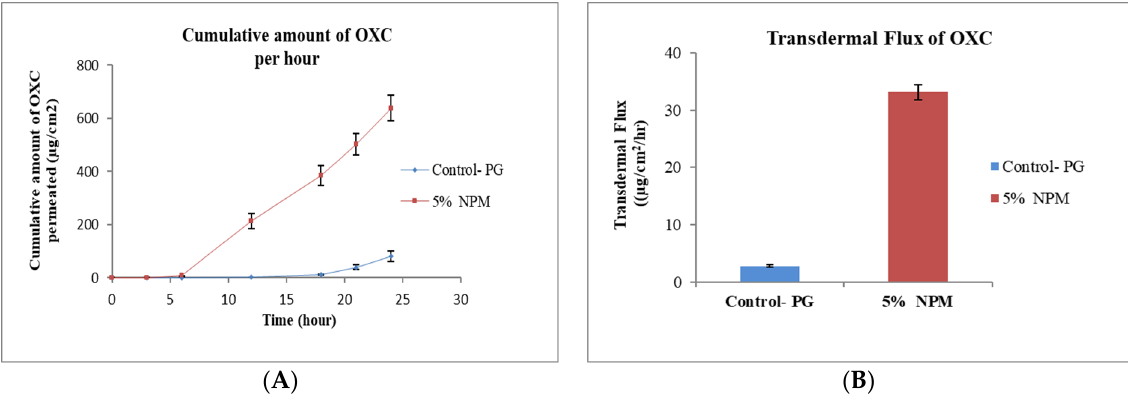
( B ) Figure 3. In vitro cumulative amount of OXC permeated per unit area versus time ( A ) and trans- dermal flux of OXC ( B ) across the human cadaver skin in presence or absence of N -Methyl 2-Pyr-